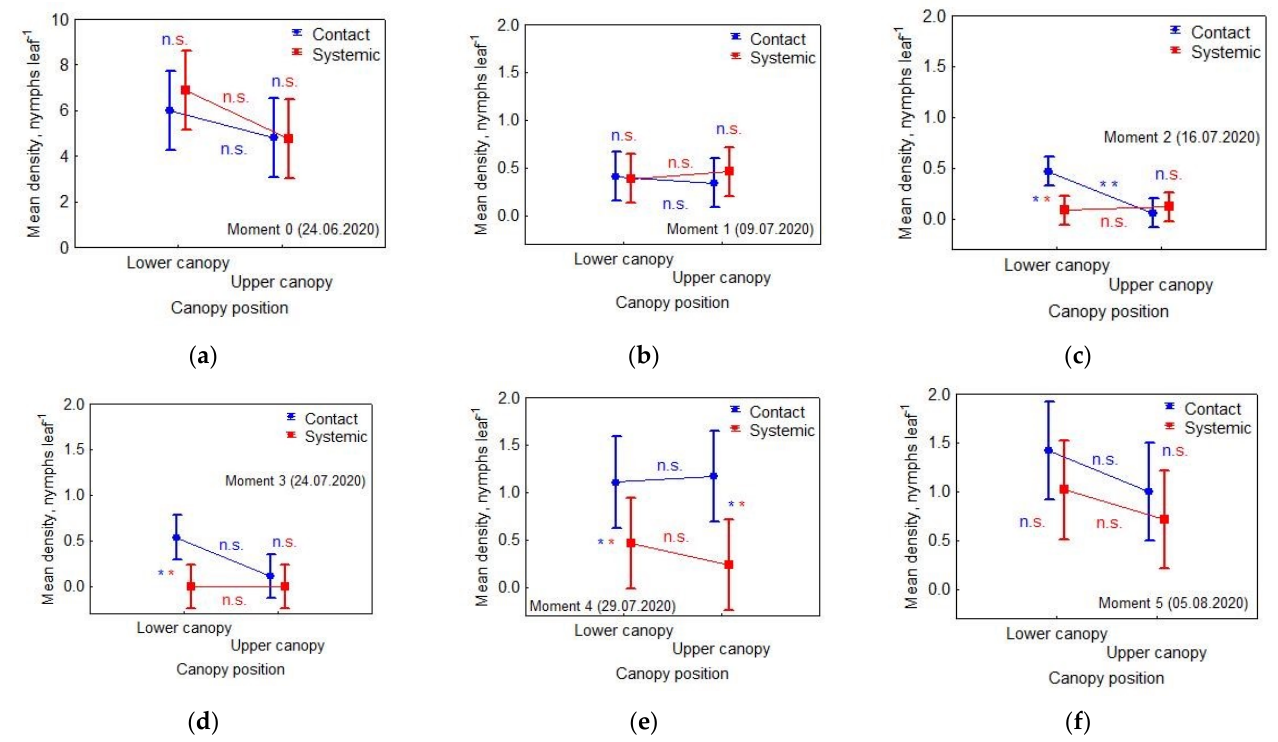
Figure 7. Effects of applied insecticide type (contact vs. systemic) on nymph density by leaf position (lower canopy vs. upper canopy) at each measurement time: ( a ) M0 (before spraying)-24 June 2020; ( b ) M1-09 July 2020; ( c ) M2-16 July 2020; ( d ) M3-24 July 2020; ( e ) M4-29 July 2020; and ( f ) M5-05 August 2020. ** = significant differences (U test, p < 0.05); n.s. = nonsignificant.